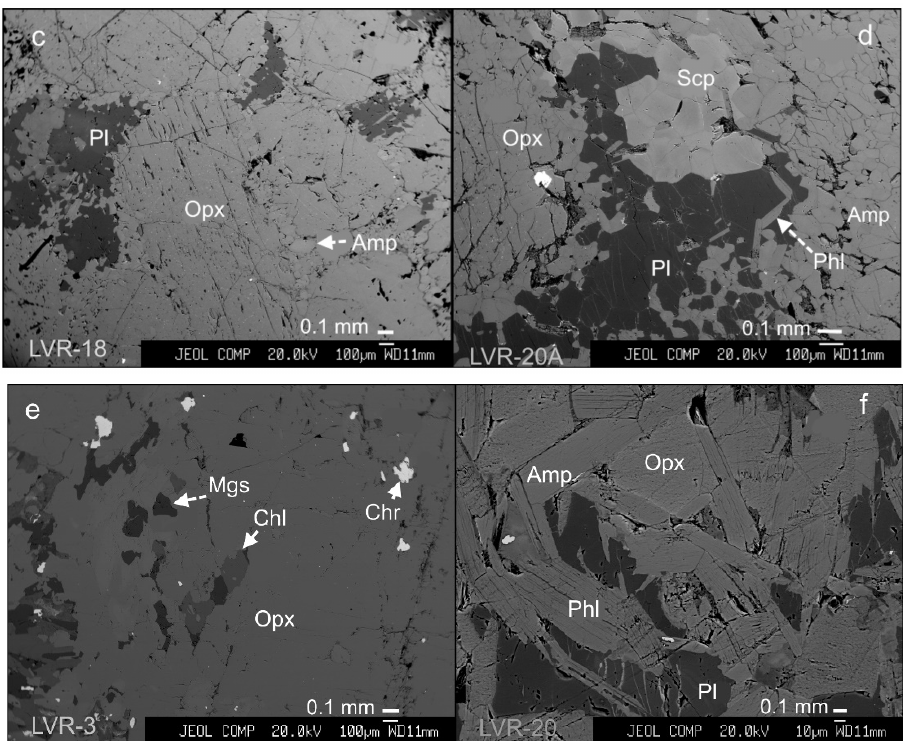
Figure 8. ( a – f ). A BSE image in ( a ) shows a sample of fine-grained orthopyroxene (Opx) coexisting with calcic amphibole (Amp). ( b ) displays a large grain of fairly fresh Opx, with inclusions of Amp, which is in contact with a compact aggregate of Amp grains; the label Chr points to accessory grains of chromian spinel. Grains of Opx ( c ) host irregular patches of plagioclase (Pl) and are replaced by Amp along the rim. Subhedral grains of interstitial plagioclase (Pl) fill the space between a large grain of Opx and an amphibole-based aggregate (Amp). Note the presence of abundant grains of scapolite (Scp) ( d ) associated with the plagioclase and platy grains of phlogopite (Phl). ( e , f ) show late assemblages of deuterically deposited magnesite (Mgs), a member of the chlorite group, Chl (corresponding to clinochlore), phlogopite (Phl), and amphibole (Amp), which are associated with orthopyroxene (Opx).